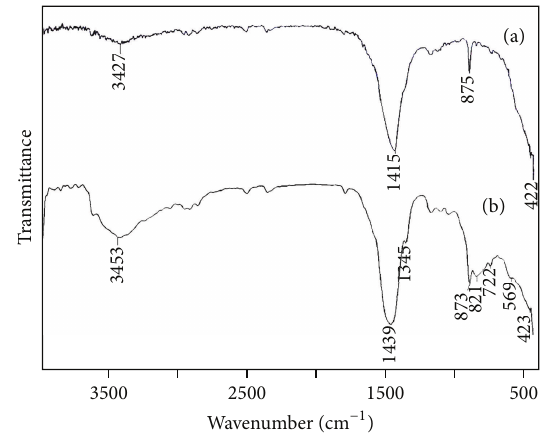
Figure 3: FTIR spectra for (a) CaO fabricated with surfactant (SDS) and (b) Al 2 O 3 ⋅ CaO nanocatalysts.